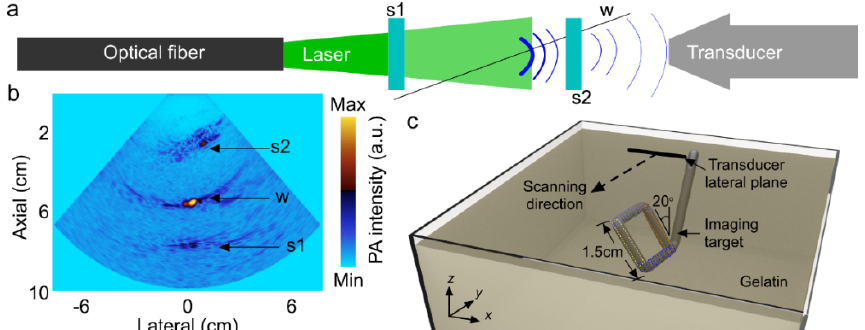
Figure 4. Experimental setup to find the optimum distance between the transducer and skull piece 2, and between the optical fiber and skull piece 1. ( a ) Schematic of the experimental setup, ( b ) photoacoustic (PA) image of the wire phantom in water with the optimum position of the transducer and optical fiber, and ( c ) a 3D model of the square loop imaging target in gelatin. Imaging target is slanted at 20° from the z axis. Scanning direction is along the x axis. Transducer lateral plane is along the y axis. s1: skull piece 1; s2: skull piece 2; w: polyactic wire. The distance between the transducer and s2 is <1.5 cm, the distance between the transducer and the imaging target is <3 cm, and the distance between the optical fiber bundle and s1 is 0.5 cm.